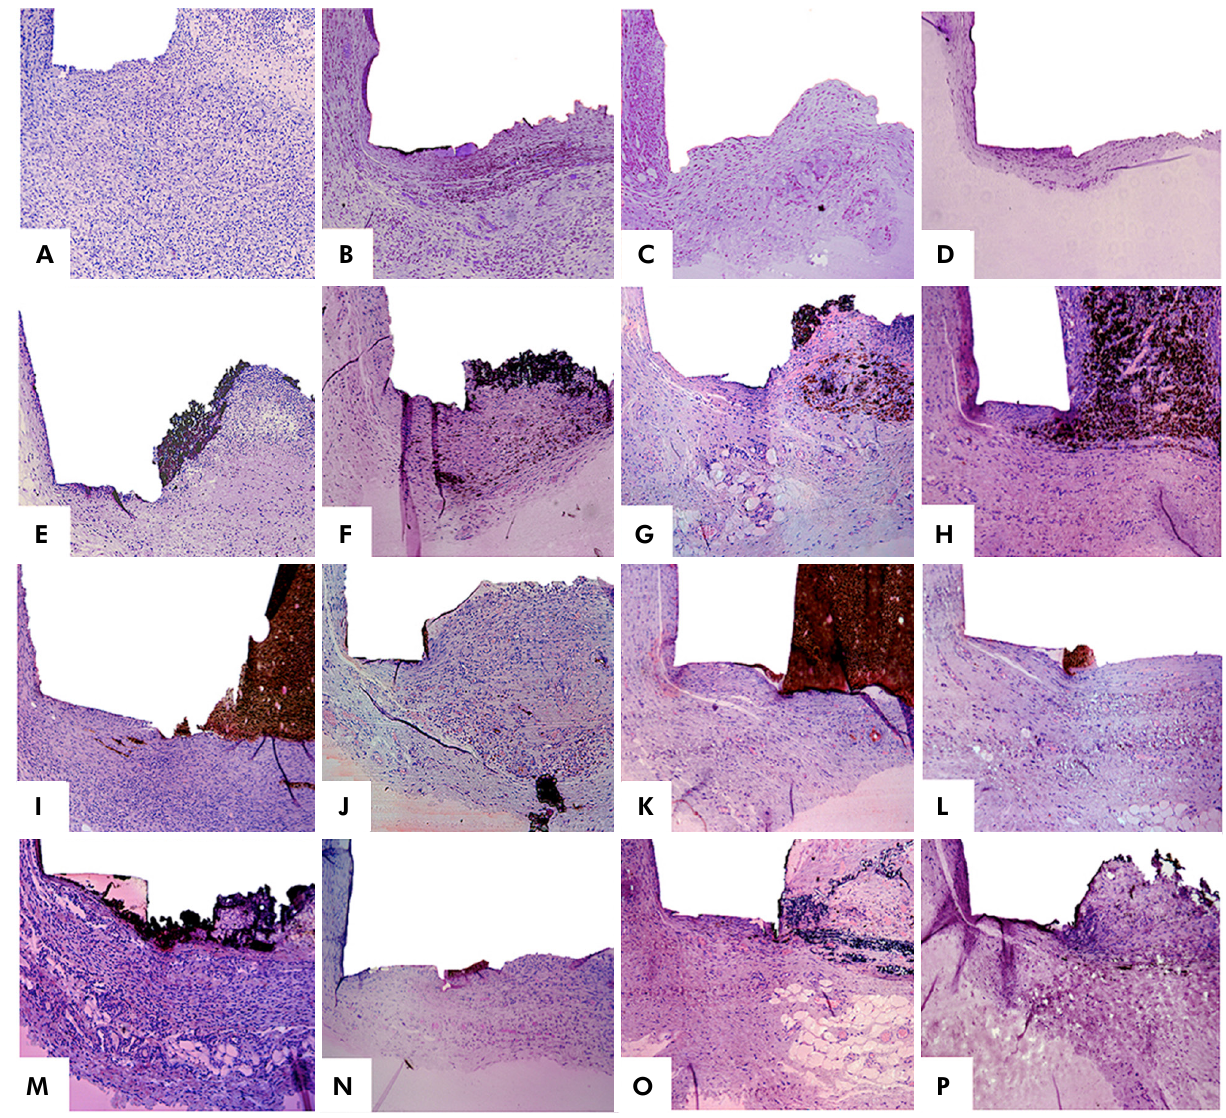
Figure 1. Subcutaneous tissue reactions in the experimental groups. Control group: (A, B) thick fibrous capsule and moderate inflammatory reaction (days 7 and 15, HE, 100 ×), (C) reduction in the thickness of the fibrous capsule and mild inflammatory reaction (day 30, HE, 100 ×), and (D) thin fibrous capsule and mild inflammatory reaction (day 60, HE, 10 ×). Sealapex: ( E, F ) thick fibrous capsule formation and moderate inflammatory cell infiltration (days 7 and 15, HE, 100 ×); ( G ) reduction in the thickness of the fibrous capsule formation and mild inflammatory cell infiltration, consisting of macrophages (day 30, HE, 100 ×); and ( H ) thin fibrous capsule formation and mild inflammatory cell infiltration, with macrophages phagocyting sealer (day 60 HE, 100 ×). Acroseal: ( I, J ) thick fibrous capsule and moderate inflammatory cell infiltration (days 7 and 15, HE, 100 ×) and ( K, L ) the fibrous capsule surrounding the tube was thin with few chronic inflammatory cells (days 30 and 60, HE, 100×). Smarpaste Bio: ( M ) thick fibrous capsule and moderate inflammatory reaction (day 7 HE, 100 ×) and ( N–P ) thin fibrous capsule and mild inflammatory reaction (days 15, 30, and 60, HE, 100